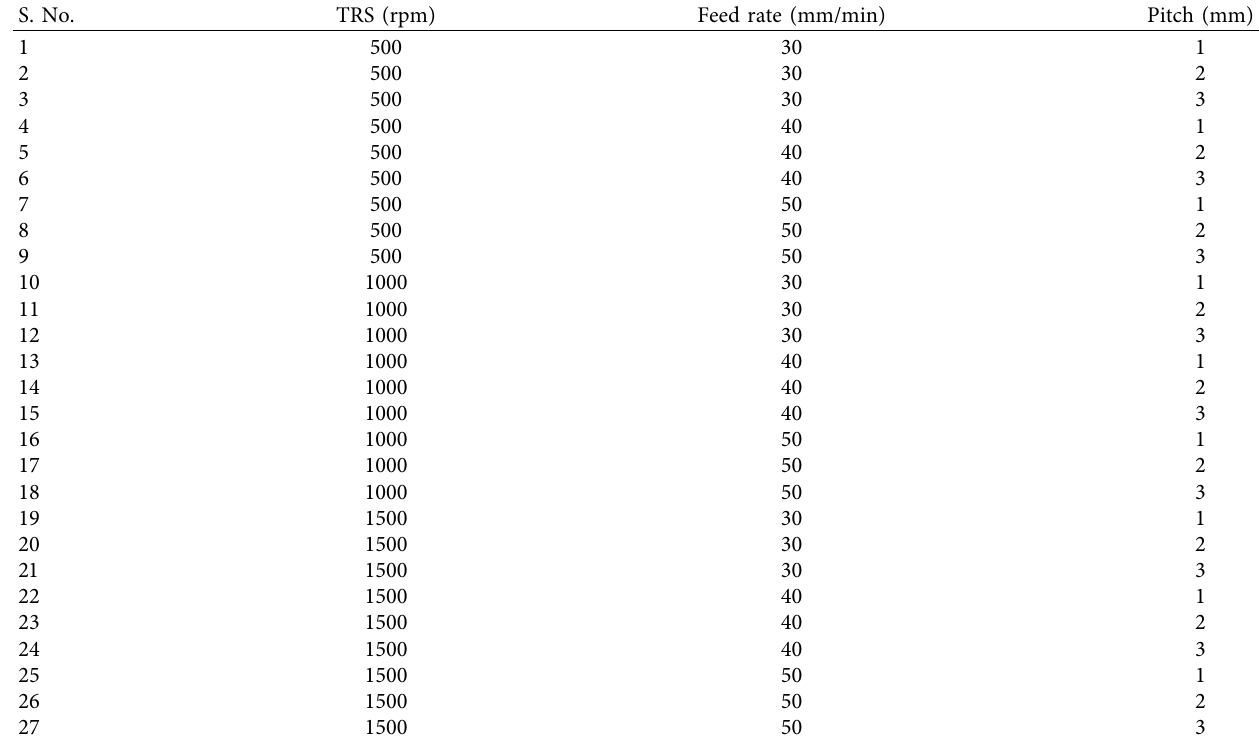
Table 2: Taguchi L 27 orthogonal